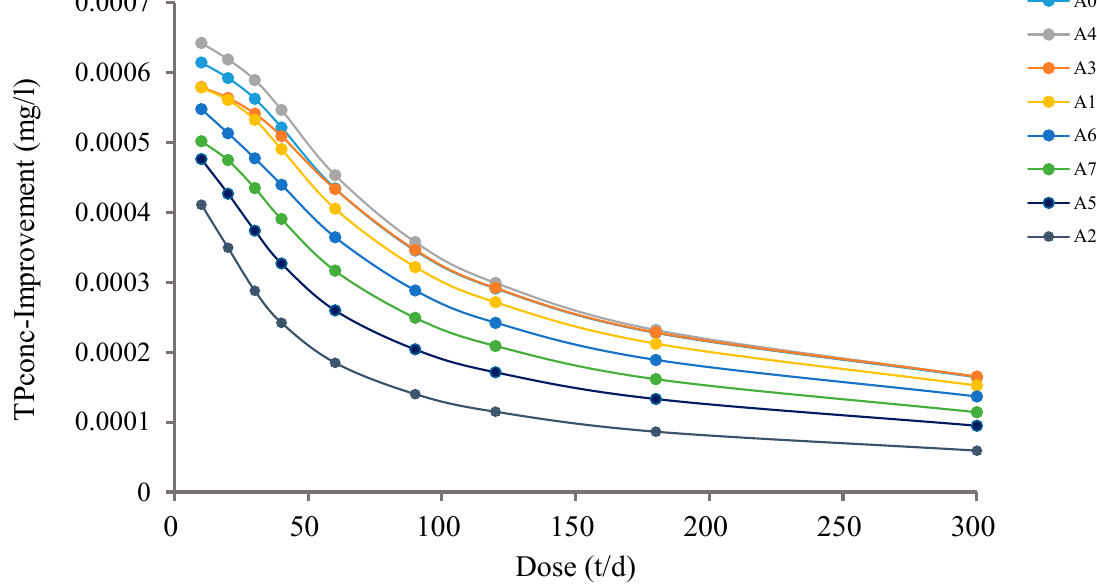
Figure 13. Response produced by Phoslock per weight for scenarios (average for simulation period, T1–T4, and base–base2).